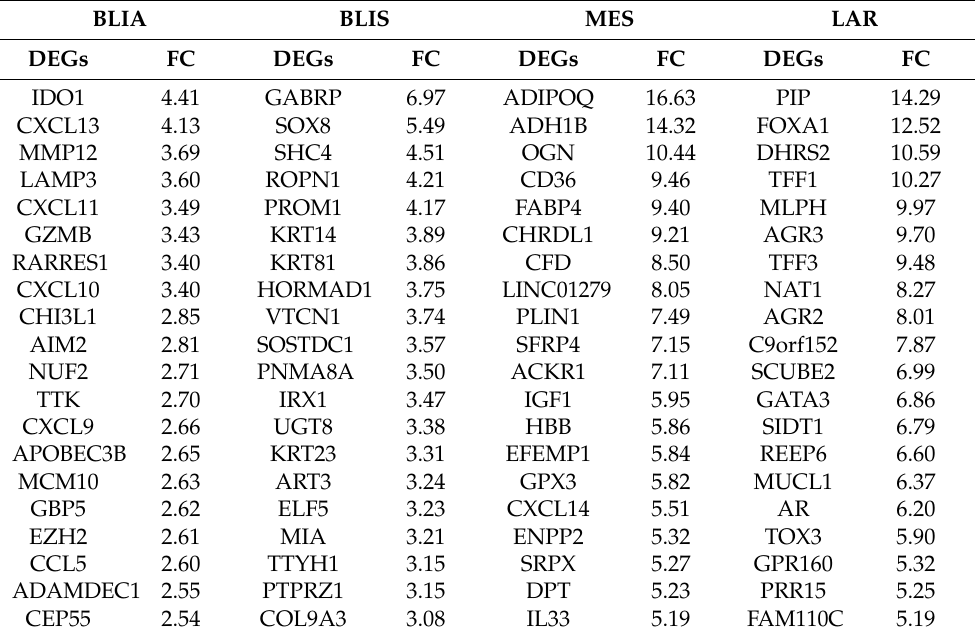
Table 1. Top 20 unique upregulated DEGs of each TNBC